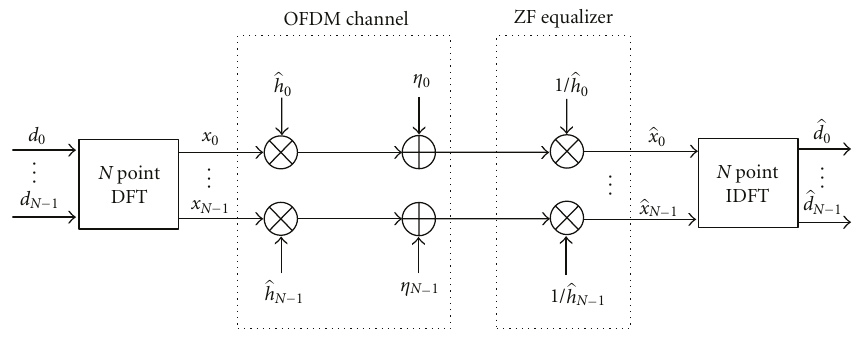
Figure 2: Equivalent block diagram of SC-FDMA